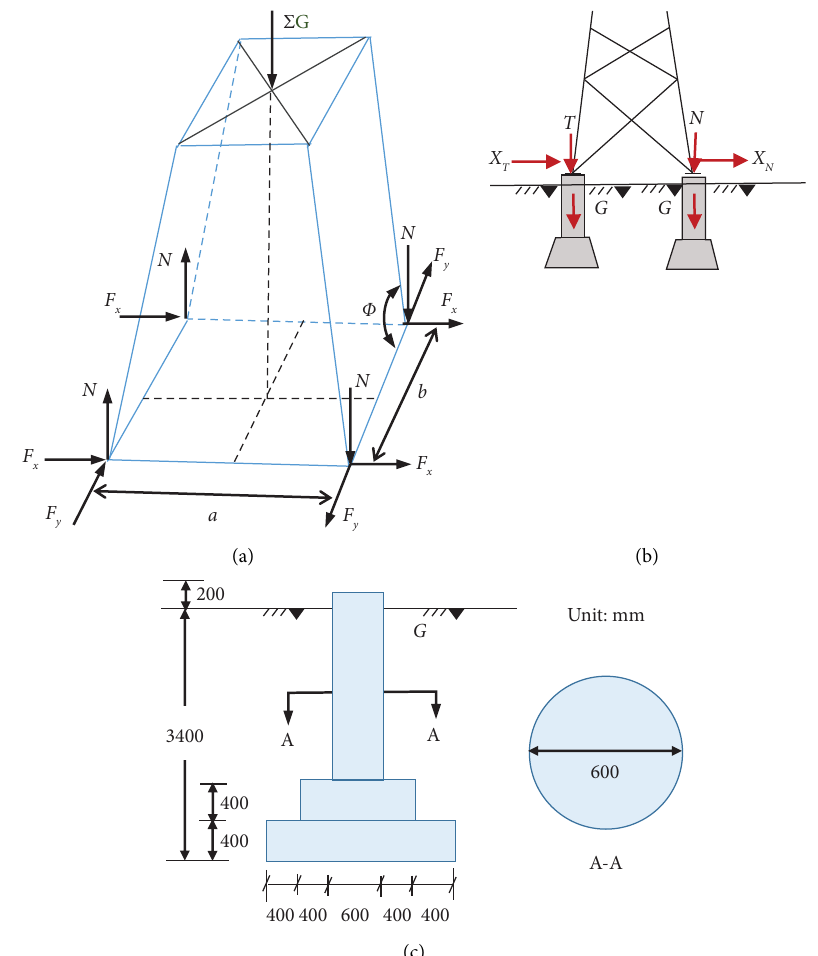
Figure 2: Te loads and foundation of the 76 # tower. (a) Te load on the tower. (b) Te load condition of tower foundation in plane. (c) Te dimensions of the tower